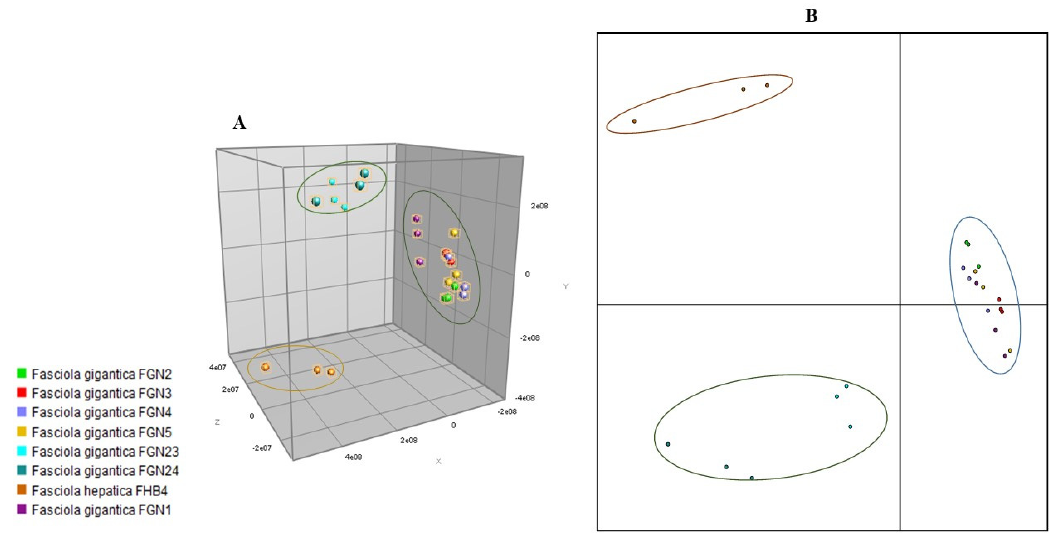
Figure 3. Statistical analysis of main spectra profiles (MSPs) obtained during the creation of an in-house database for identification of adult Fasciola gigantica (FG) and Fasciola hepatica (FH) using MALDI-TOF MS. ( A ) Three-dimensional view of a principal component analysis, displaying three distinct clusters, i.e., (i) F. hepatica FHB4; (ii) F. gigantica FGN23 and FGN24; and (iii) the remaining F. gigantica samples. ( B ) Two-dimensional view of a discriminant analysis, using the same samples. The analyses were carried out using the software BioNumerics.